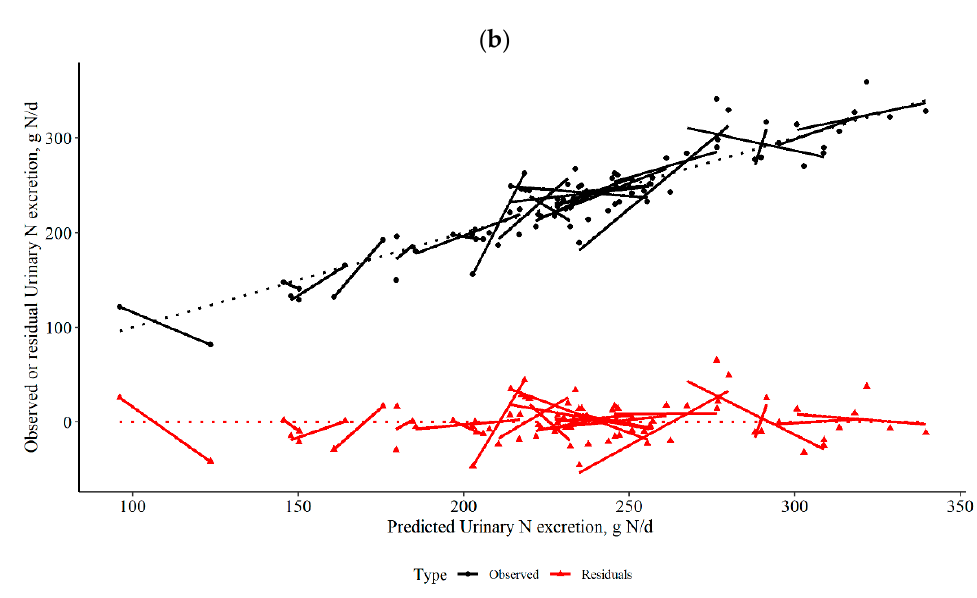
Figure 5. ( a ) Observed ( ● . black) or residual ( ▲ . red) Nitrogen use efficiency (NUE. %) versus pre ‐ dicted values of model described in Table 7; ( b ) Observed ( ● . black) or residual ( ▲ . red) urinary N excretion (g N/d) versus predicted values of model described in Table 7. The solid lines represent individual studies, while points represent the different treatments within each study. The dotted lines represent the line of unity.